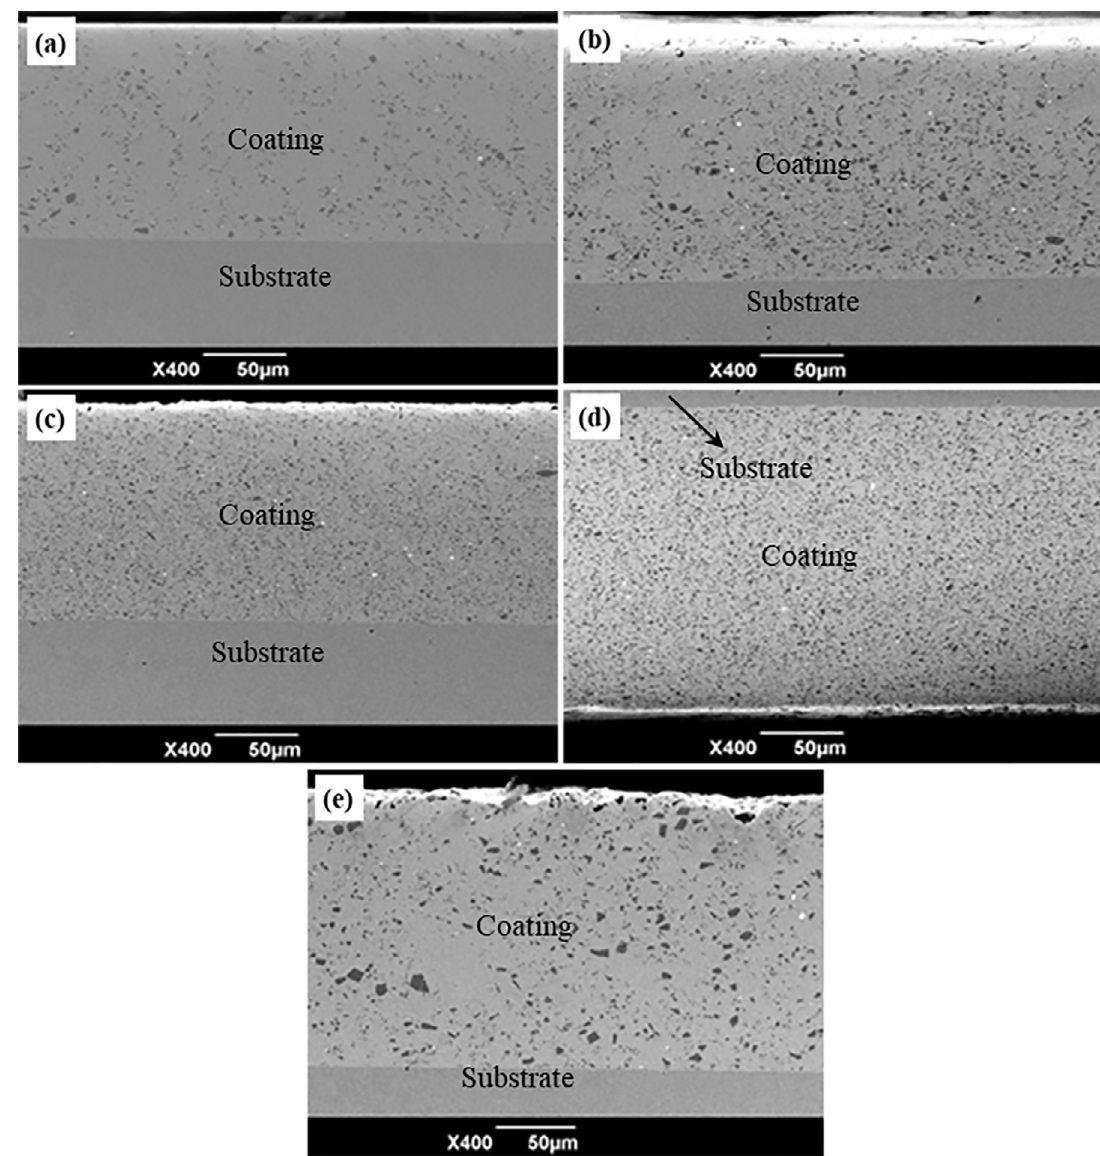
Figure 7. Cross-section SEM images of composite coatings with different TiC particles concentration in solution: (a) 8 g/L; (b) 16 g/L; (c) 24 g/L; (d) 32 g/L and (e) 40